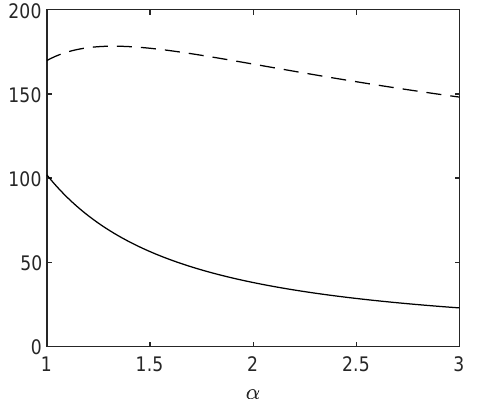
(cid:82) 1 π B ( t ) dt (dashed curve), as 0